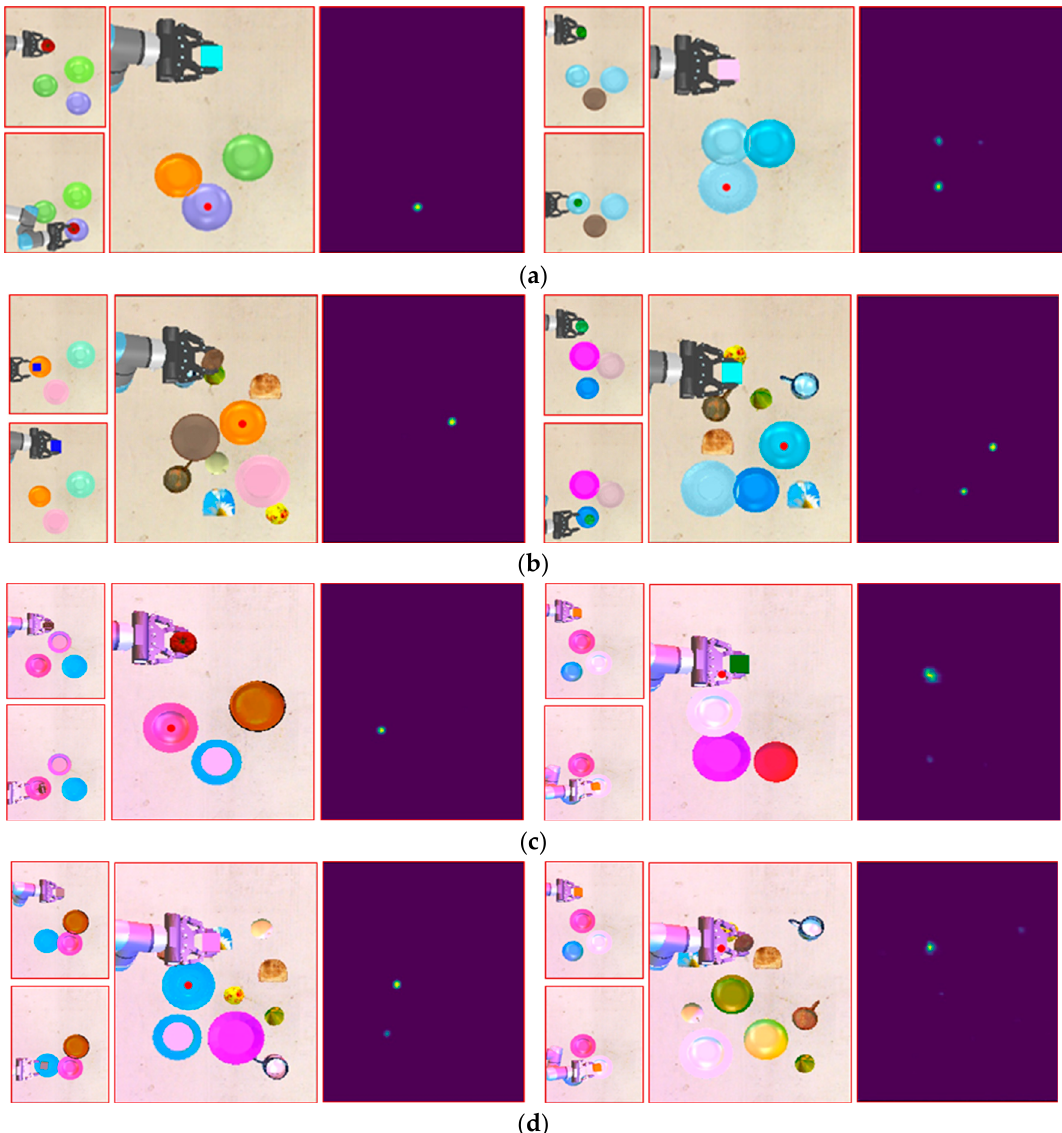
Figure 11. Examples of the detection network in different scenes. ( a ) Examples of detection network in trained scene with two distractors; ( b ) Examples of detection network in trained scene with multiple objects; ( c ) Examples of detection network in new scene with two distractors; ( d ) Examples of detection network in new scene with multiple objects.